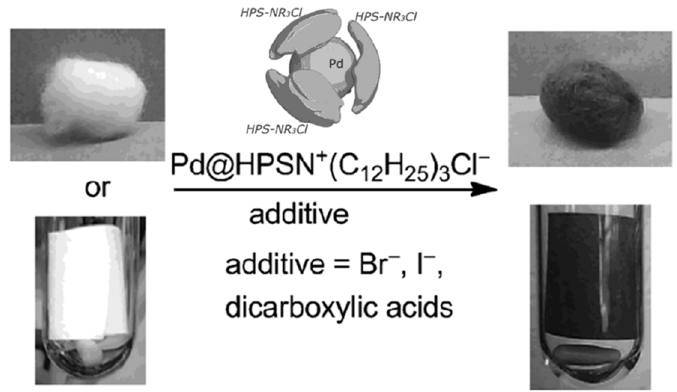
Figure 8. Preparation of dispersible Pd@HPS-NR 3+ Cl − and its immobilization on cellulose (cotton wool or filter paper) [70].